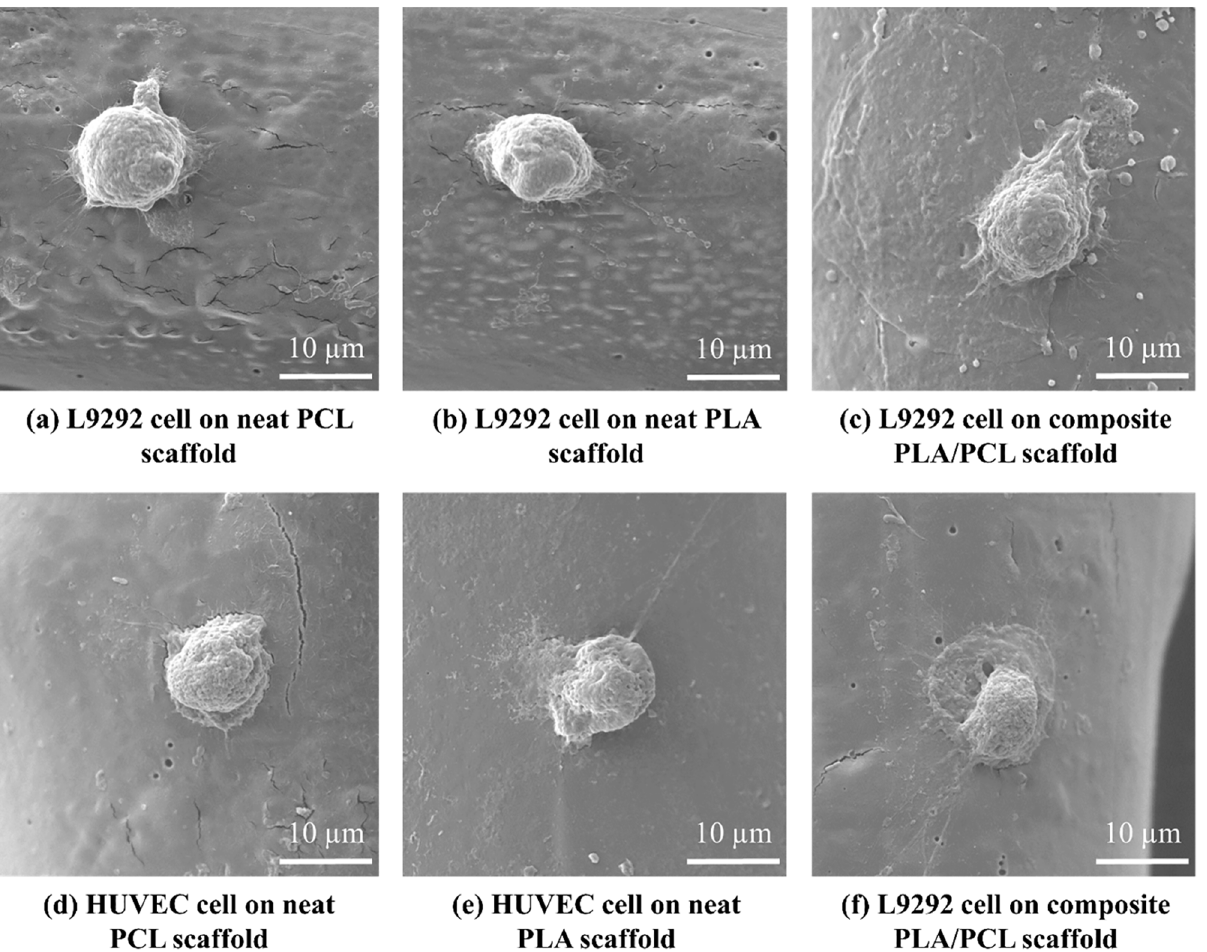
Figure 7. ( a–c ) L929 cells adhesion to the surface of the neat PCL, neat PLA, and composite PLA/PCL scaffolds, respectively, and ( d–f ) attachment of HUVEC cells to the surface of the neat PCL, neat PLA, and composite PLA/PCL scaffolds,